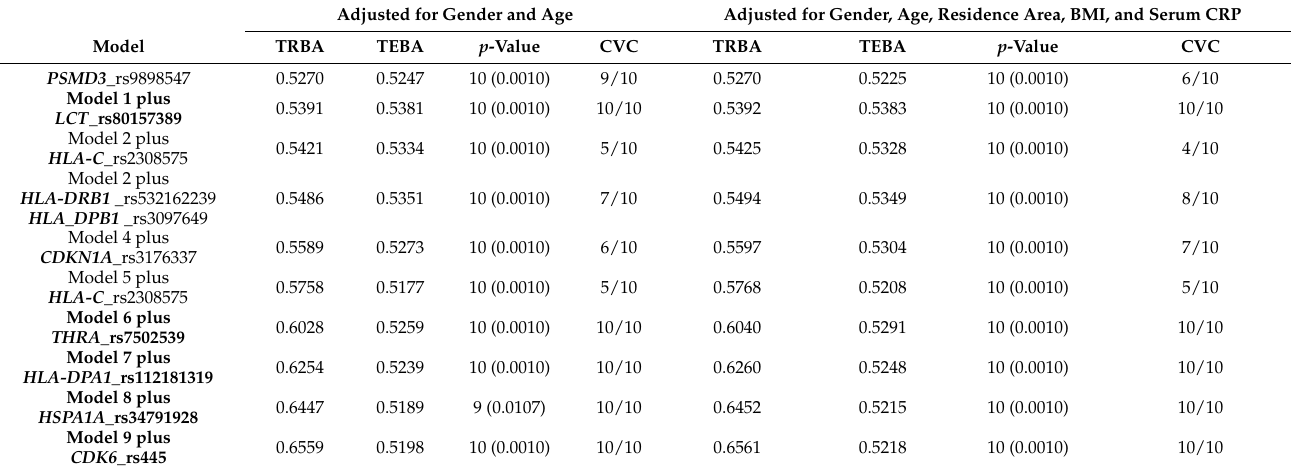
TRBA, trained balanced accuracy; TEBA, test balance accuracy; CVC, cross-validation consistency; sign test, result, and p -value for the significance of GMDR model by sign test with and without adjusting for covariates designated; BMI, body mass index. Bold faces indicated the best models.